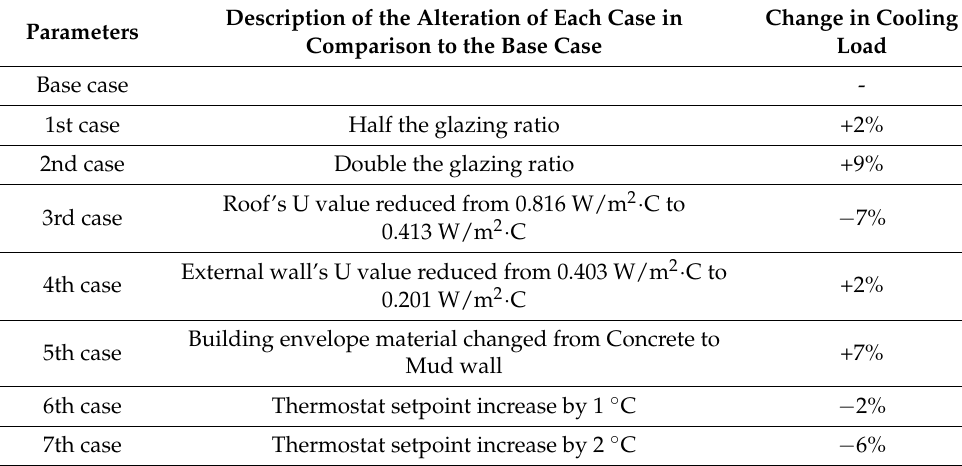
Table 6. Application of improvement cases into Hudhayfah Mosque simulation model.